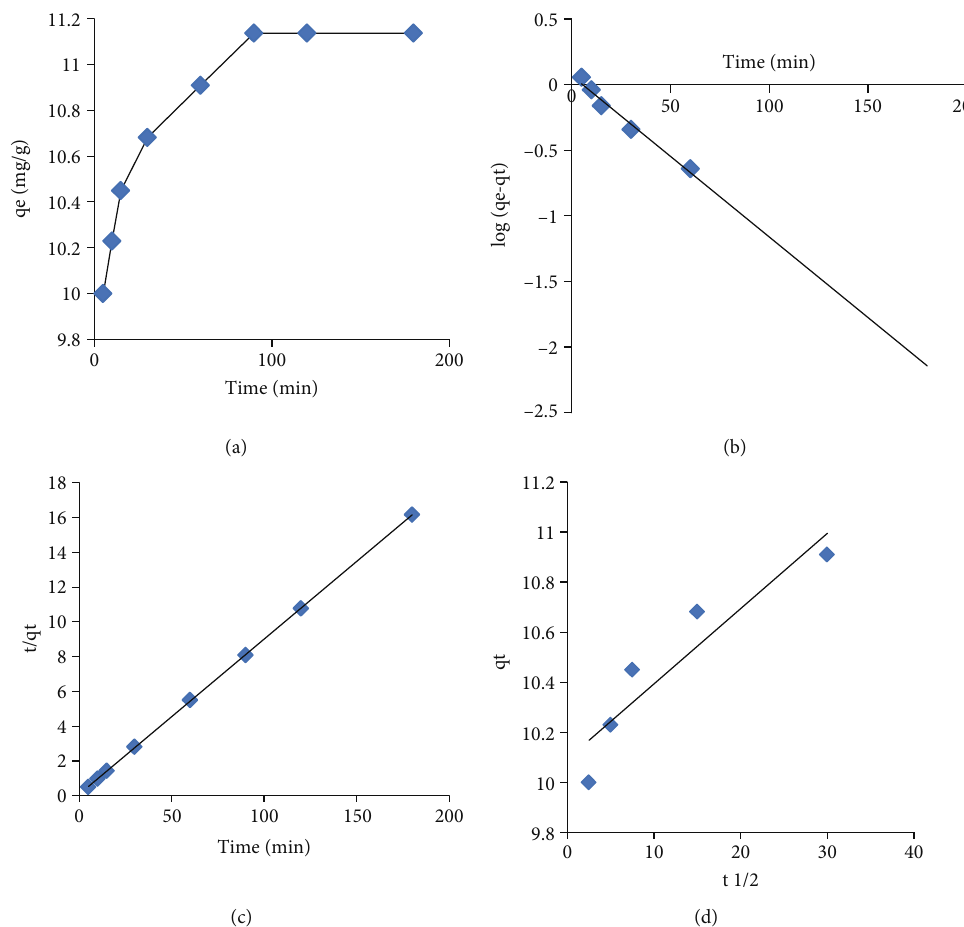
Figure 6: (a) E ff ect of contact time; (b) pseudo- fi rst-order kinetics; (c) pseudo-second-order kinetics; (d) intraparticle di ff usion model for the adsorption of methylene blue onto Neolamarckia cadamba. Table 4: Kinetic parameters for the removal of methylene blue on Neolamarckia cadamba leaves.